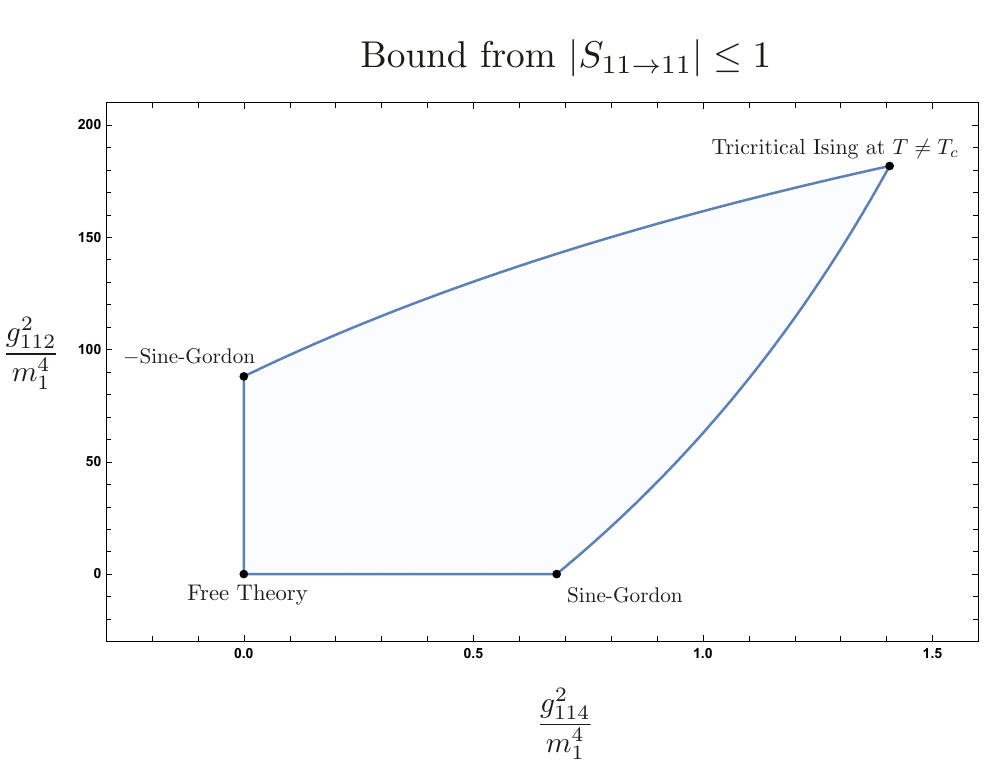
Figure 23. Space of allowed couplings compatible with